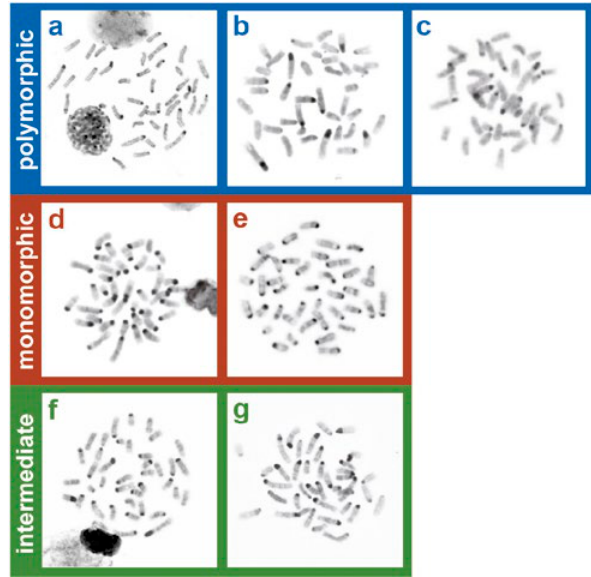
Fig. 3. Typical examples of C-banded metaphase plates of poly- morphic patterns: Seongmodo Is. (a, HEG007-97), Ohba (b, MAI- 1306), and Takinosato (c, MAI-1293); monomorphic patterns: C57BL/6N (d, MAI-1301) and Niikappu-2 (e, MAI-2004); and intermediate patterns: a hybrid mouse (f, MAI-1379) and Hayakita (g,